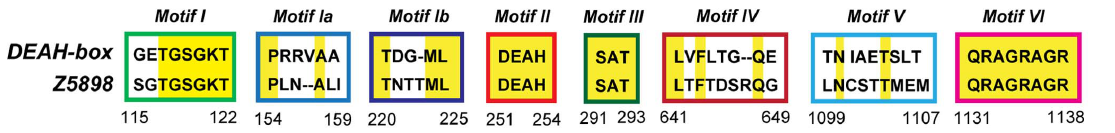
Figure 2. Schematic representation of conserved DEAH-box RNA helicase motifs in the Z5898 of E.coli O157:H7 EDL933. The DEAH- box conserved motifs are described by Cordin et al . [58]. The sequence and location of conserved motifs of the DEAH-box family aligned with Z5898 are shown. The yellow shadow show the perfect matches. The numbers below the boxes are amino acid positions of Z5898.